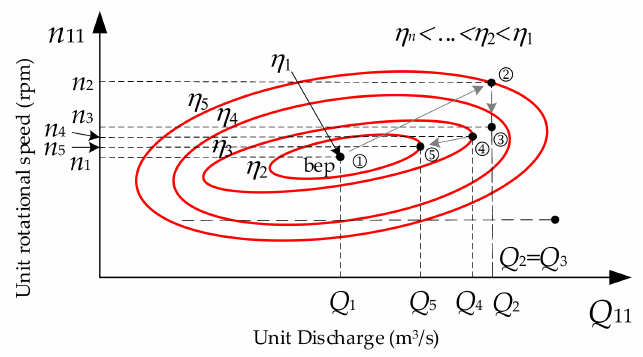
Figure 1. Hill diagram showing the topographic curves of e ffi ciency for a pump–turbine operating in the turbine